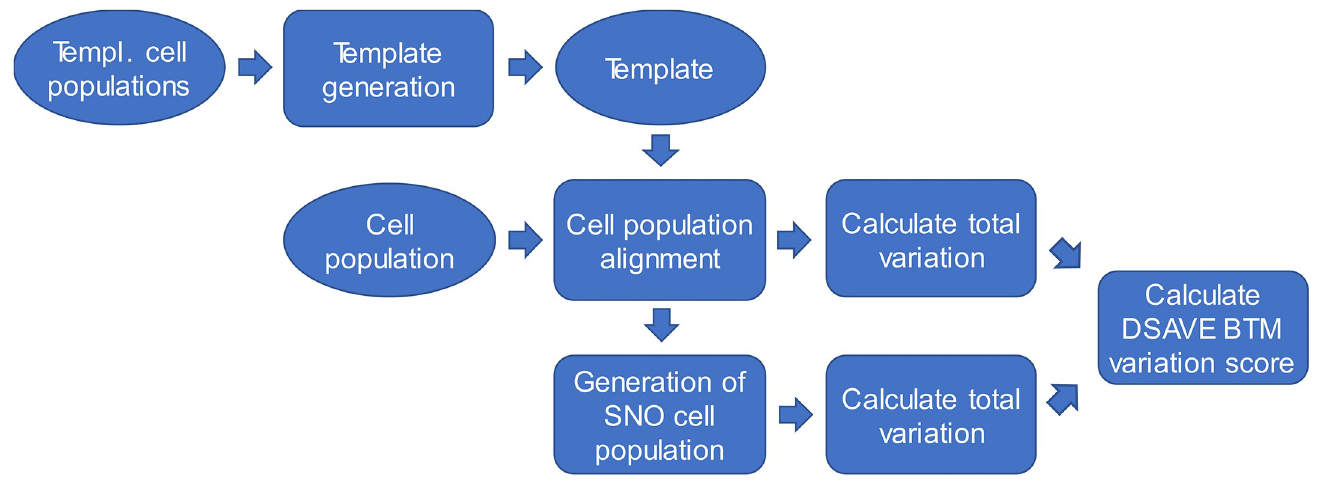
Fig 2. Overview of the calculation of the DSAVE variation score. Oval shapes represent data, while rounded rectangles represent calculations.